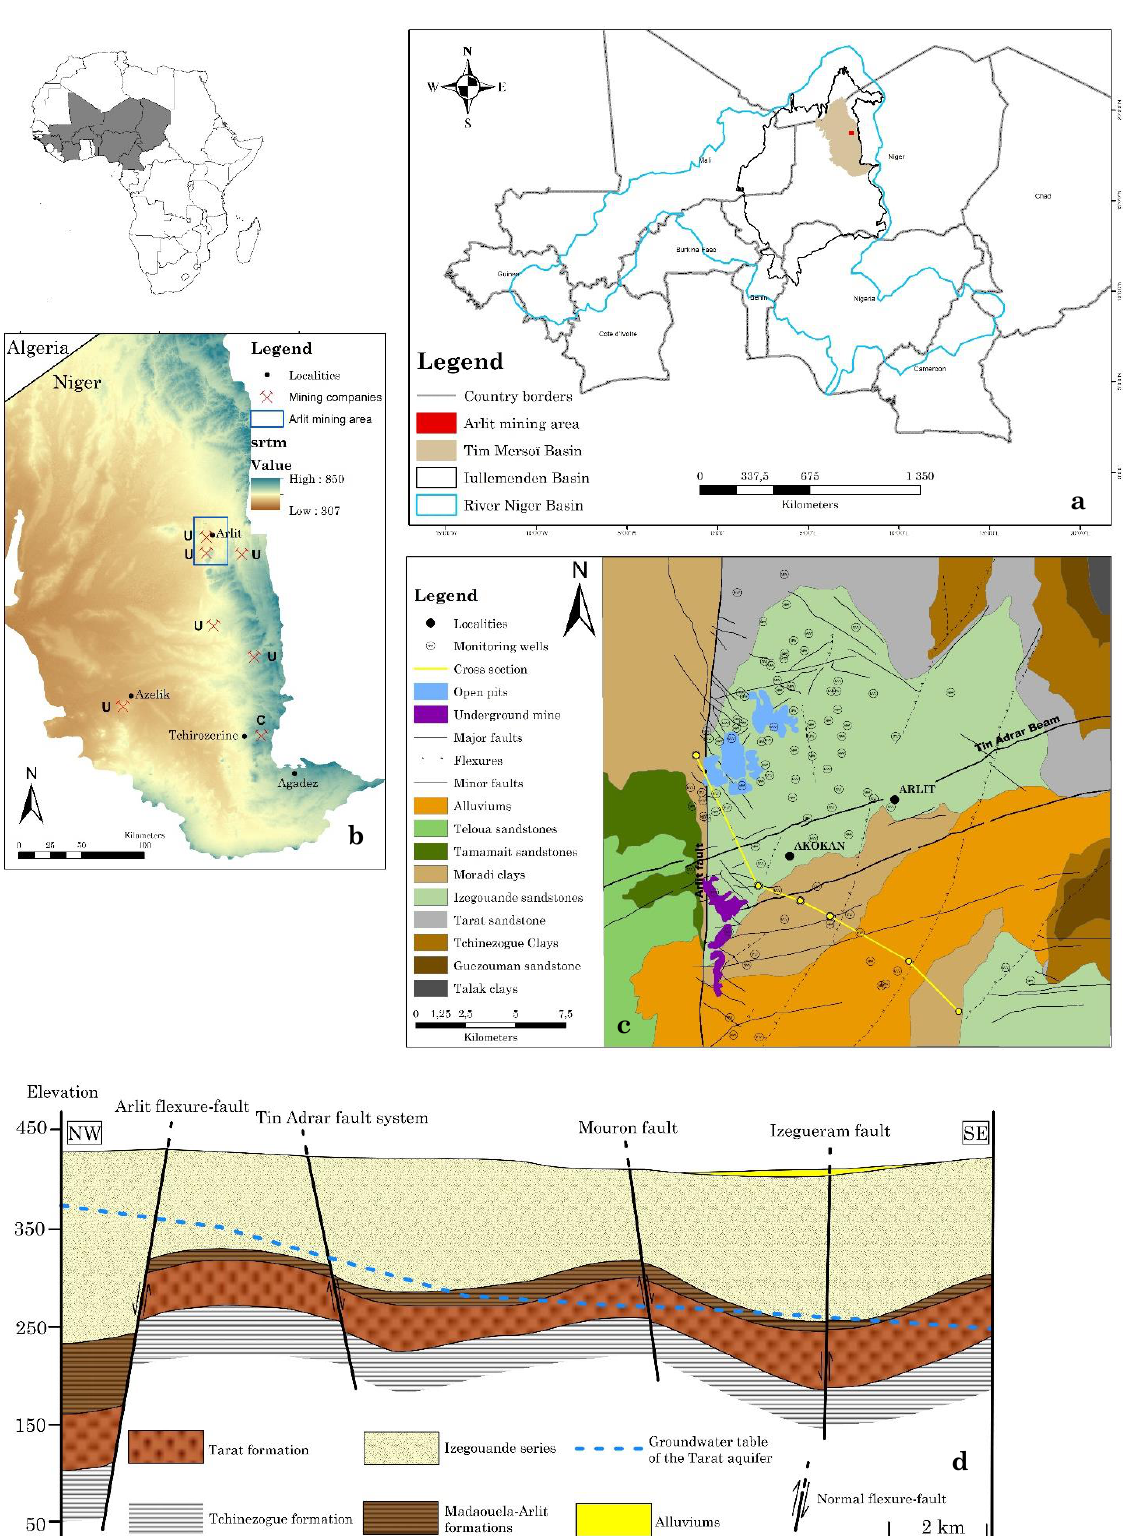
Figure 1. Location of the study area within the west African context ( a ). Distribution of the mining areas (U, uranium; C, coal), including the Arlit mining area within it; the elevations in this area are color-coded ( b ). The geological setting of the Arlit region and the spatial repartition of the monitoring wells are presented ( c ). A hydrogeological cross-section of the Tarat aquifer is presented with the groundwater heads measured in December 2019 ( d ).